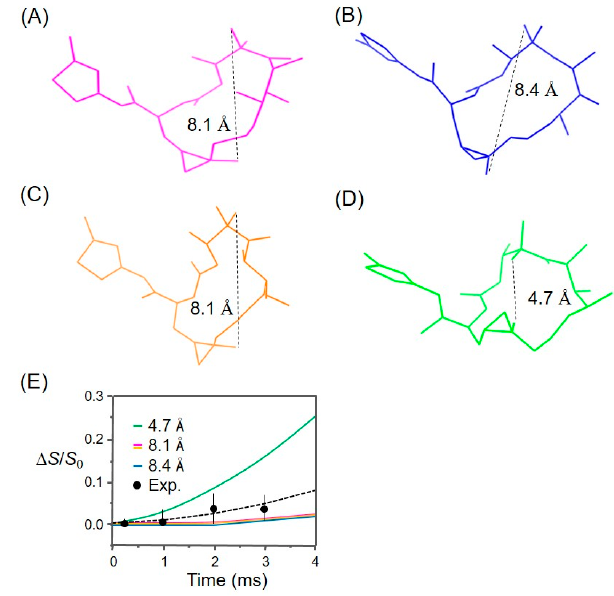
Figure 6. Comparison of the experimental REDOR data with protein-bound conformations of epothilones in the literature. ( A ) Cytochrome P450epoK-bound epothilone B (PDB 1Q5D); ( B ) T 2 R-TTL-EpoA complex (PDB 4I50); ( C ) Tubulin-bound epothilone A [20]; ( D ) Tubulin-bound epothilone A in zinc-stabilized 2D sheets (PDB 1TVK); and ( E ) The SIMPSON curves of 2 H{ 19 F} REDOR dephasing calculated as a function of the dipolar evolution time for the above four conformers. For a systematic comparison, 26-methyl was added to the known structures of epothilone A ( B – D ). A shorter distance between the 26-fluoromethyl to the germinal trideuteriomethyl groups (C-22 and C-23) is displayed by dotted lines with the marked value. The error bars shown in the difference ( ∆ S ) spectra ( E ) represent one standard deviation of the noise levels from the peak maxima.